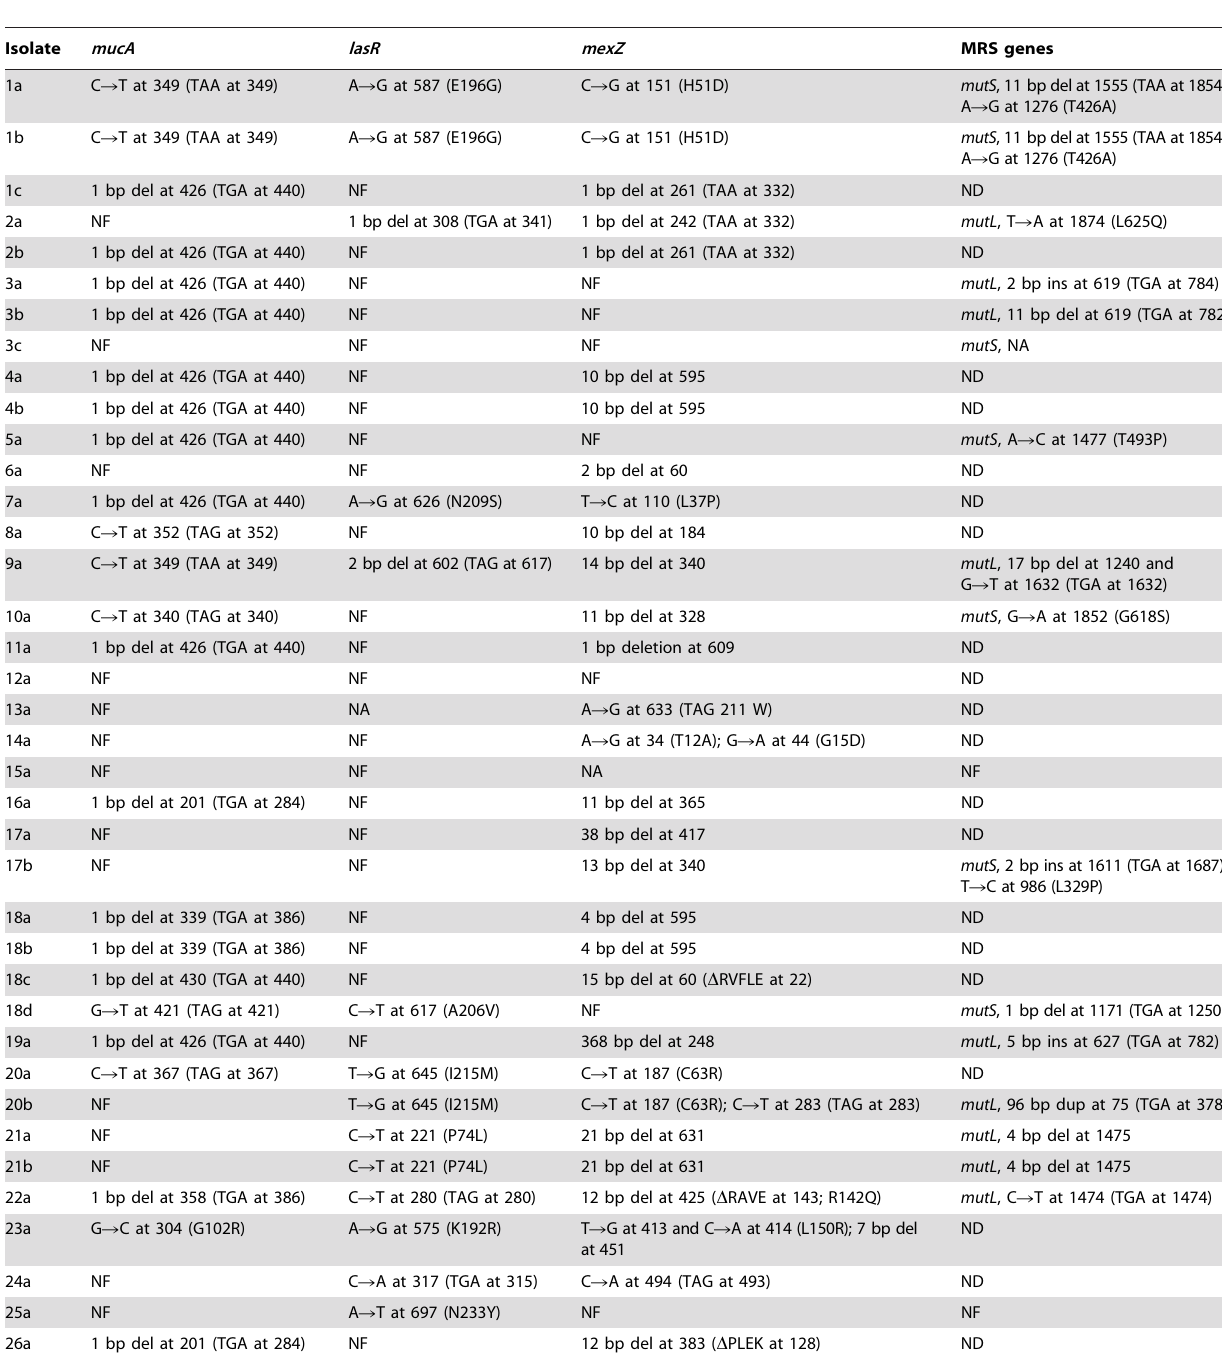
Table 2. Mutations in the mucA , lasR and mexZ genes of the 38 P. aeruginosa CF isolates.